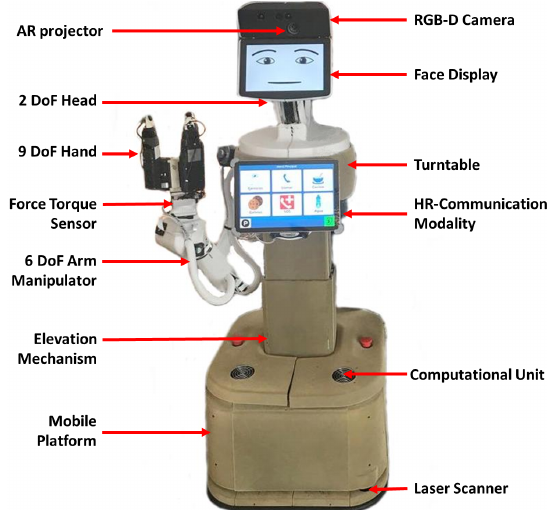
Figure 2. The basic architectural elements of the RAMCIP robot. The robotic platform with the eleva- tion mechanism, the turntable, the arm manipulator and the head have been developed by ACCREA Engineering © . The utilized hand is the smart grasping system of SHADOW Robot Company, Ltd. ©